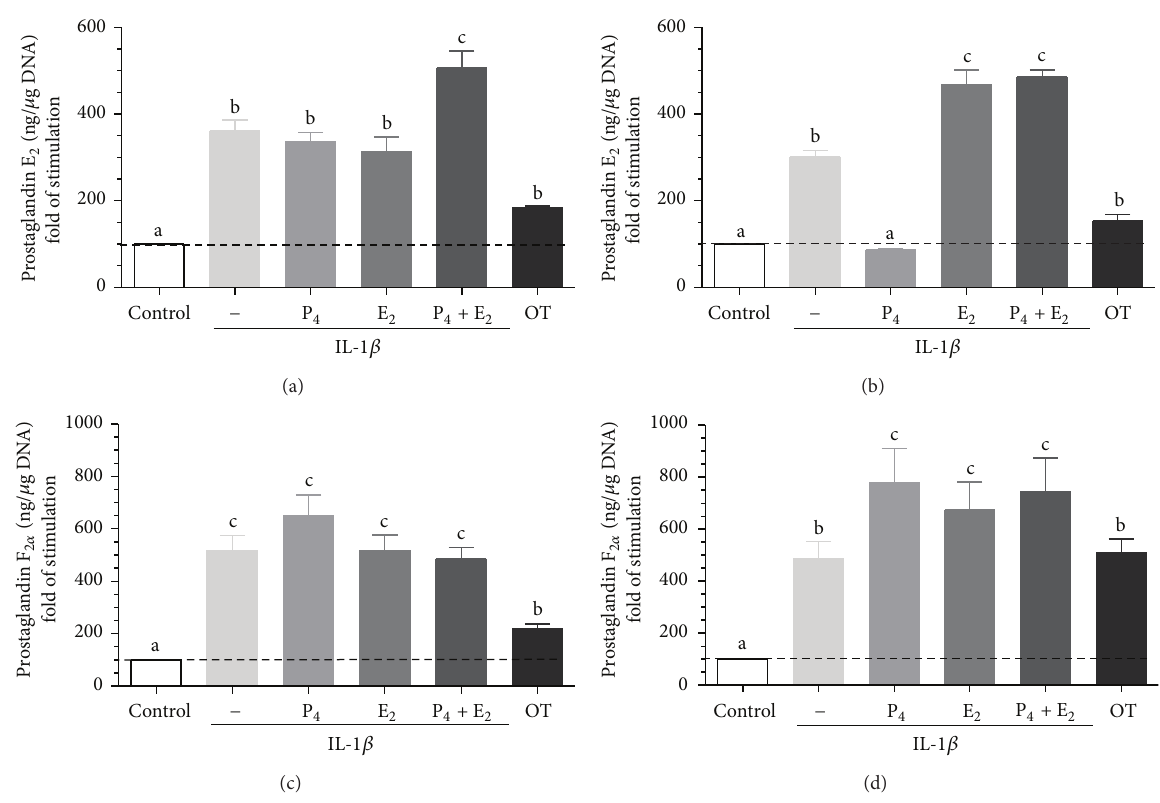
Figure 4: The effect of ovarian steroids on IL-1 𝛽 stimulated PGE 2 and PGF 2𝛼 production by epithelial ((a), (c)) and stromal ((b), (d)) cells. The cells were treated with P 4 (10 −7 M), E 2 (10 −9 M), or P 4 + E 2 (10 −7 /10 −9 M) for 24 h. Then, the medium was replaced with a fresh medium and the epithelial cells were stimulated with IL-1 𝛽 (10ng/mL) for 24h. Oxytocin (OT; 10 −7 M) was used as a positive control. All values are expressed as n- fold change from control. letters “a,” “b,” “c” indicate significant differences ( 𝑃 < 0.05 ) between groups, as determined by parametric one-way ANOVA followed by Newmann-Keuls comparison